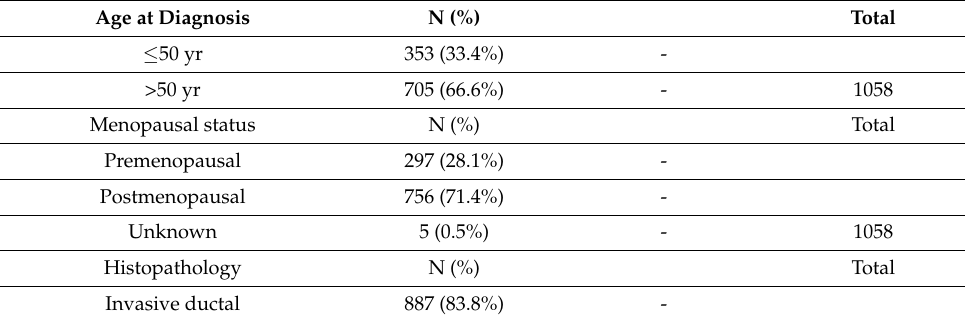
Table 1. Characteristics of patients with breast